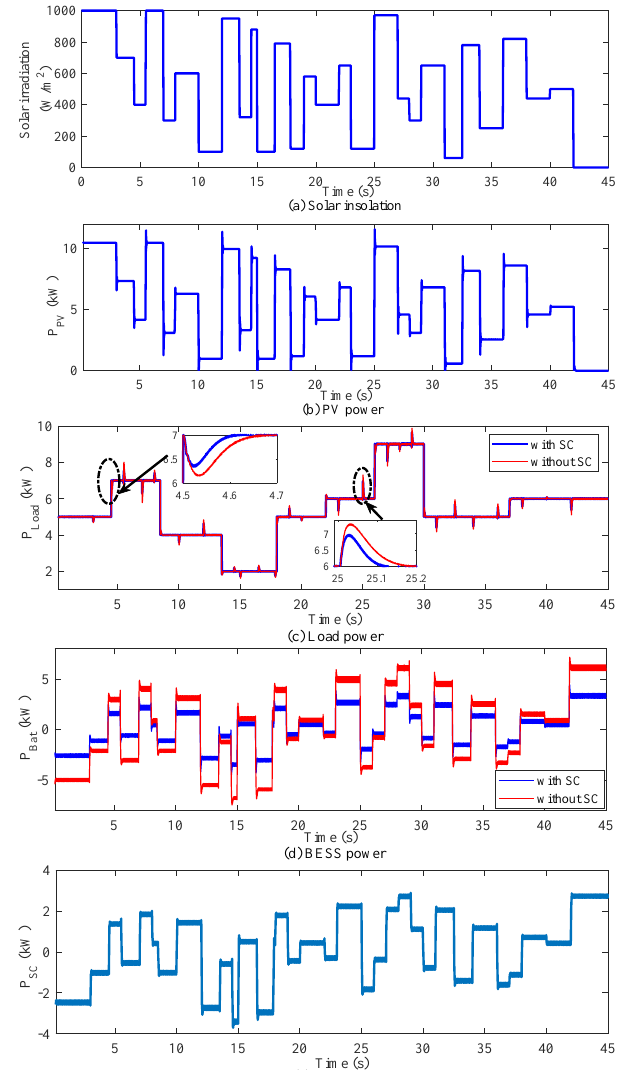
Figure 9. Power responses of different components within the DC microgrid under different operating conditions considering more fluctuations in the solar